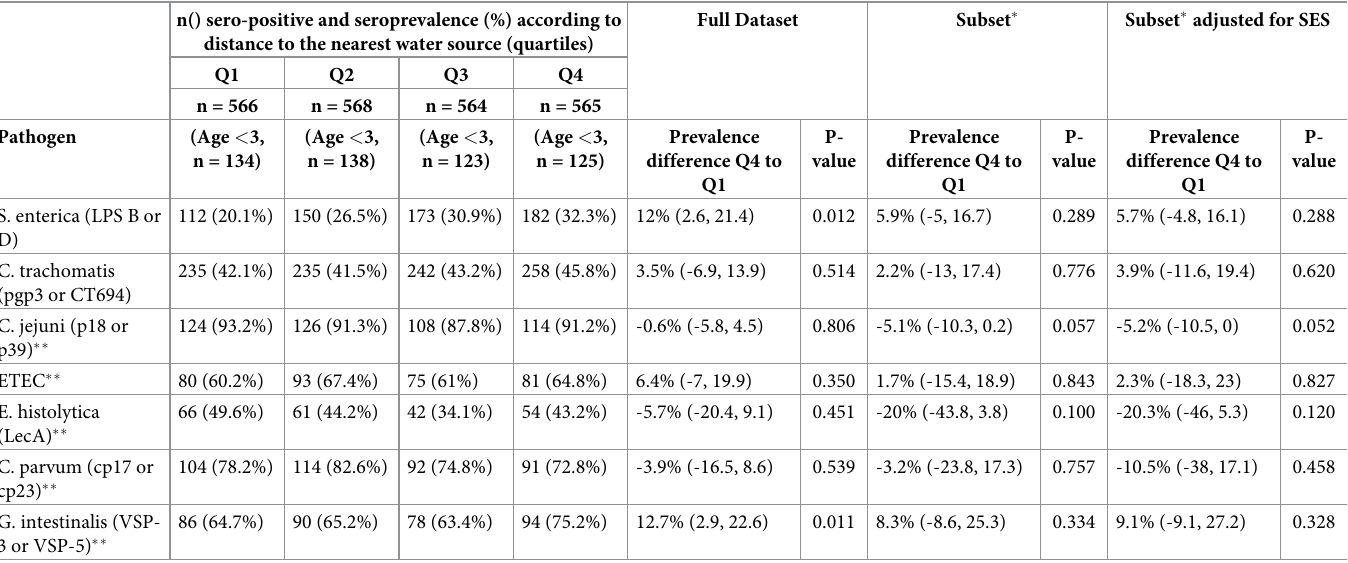
All prevalence difference estimates are adjusted for age and account for variation in the standard error due to clustering by community. � Subset = random 33% of households with socioeconomic status information